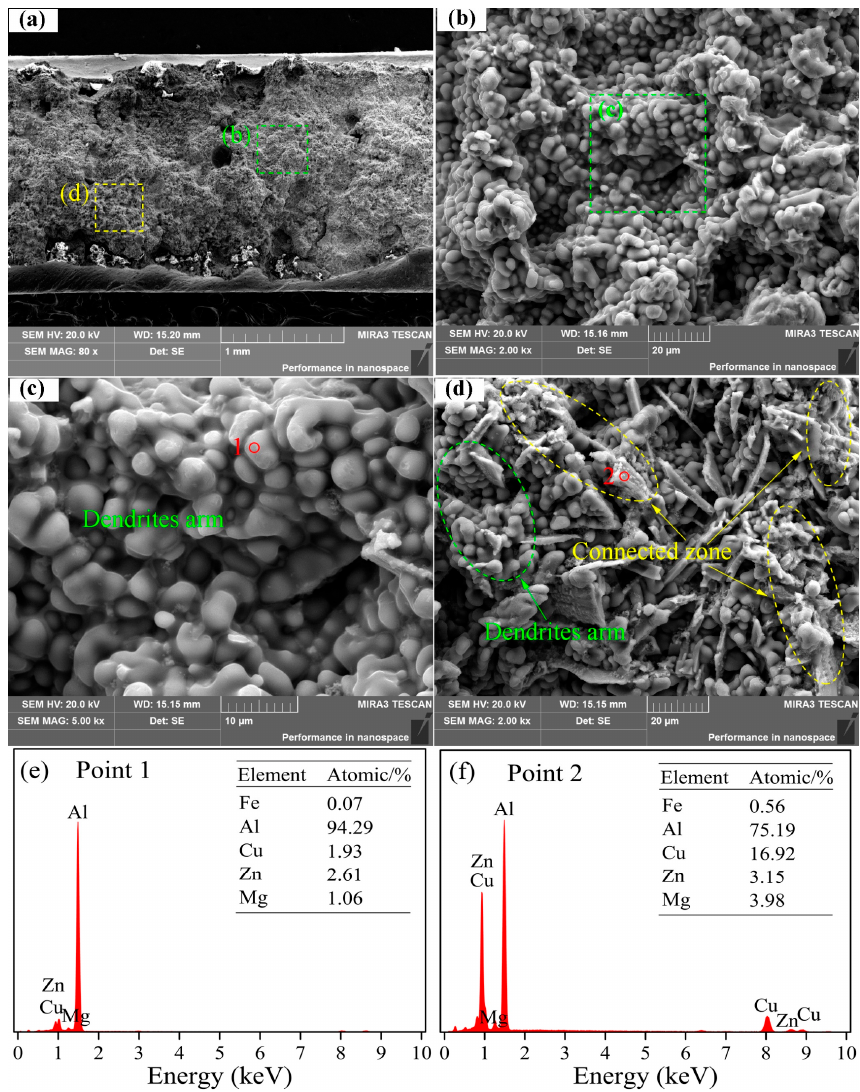
Figure 10. Fracture surface of the welded joint with the 0.1 mm brass interlayer. ( a ) Overall fracture on the aluminum side, ( b , d ) magnified views of the regions with the dotted square in ( a ), ( c ) a magnified view of the region with the dotted square in ( b ), and ( e ) and ( f ) the EDS results of point 1 and 2 as marked in ( c ) and ( d ), respectively.